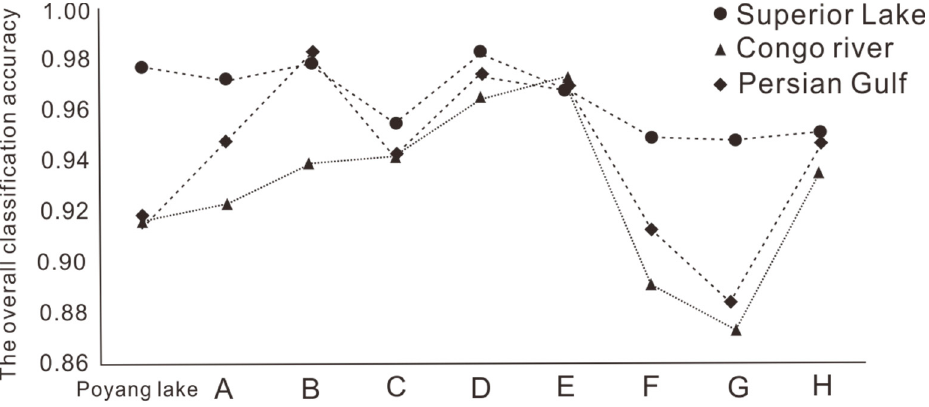
Figure 15. The overall classification accuracy of the water spectrum based on different standards.